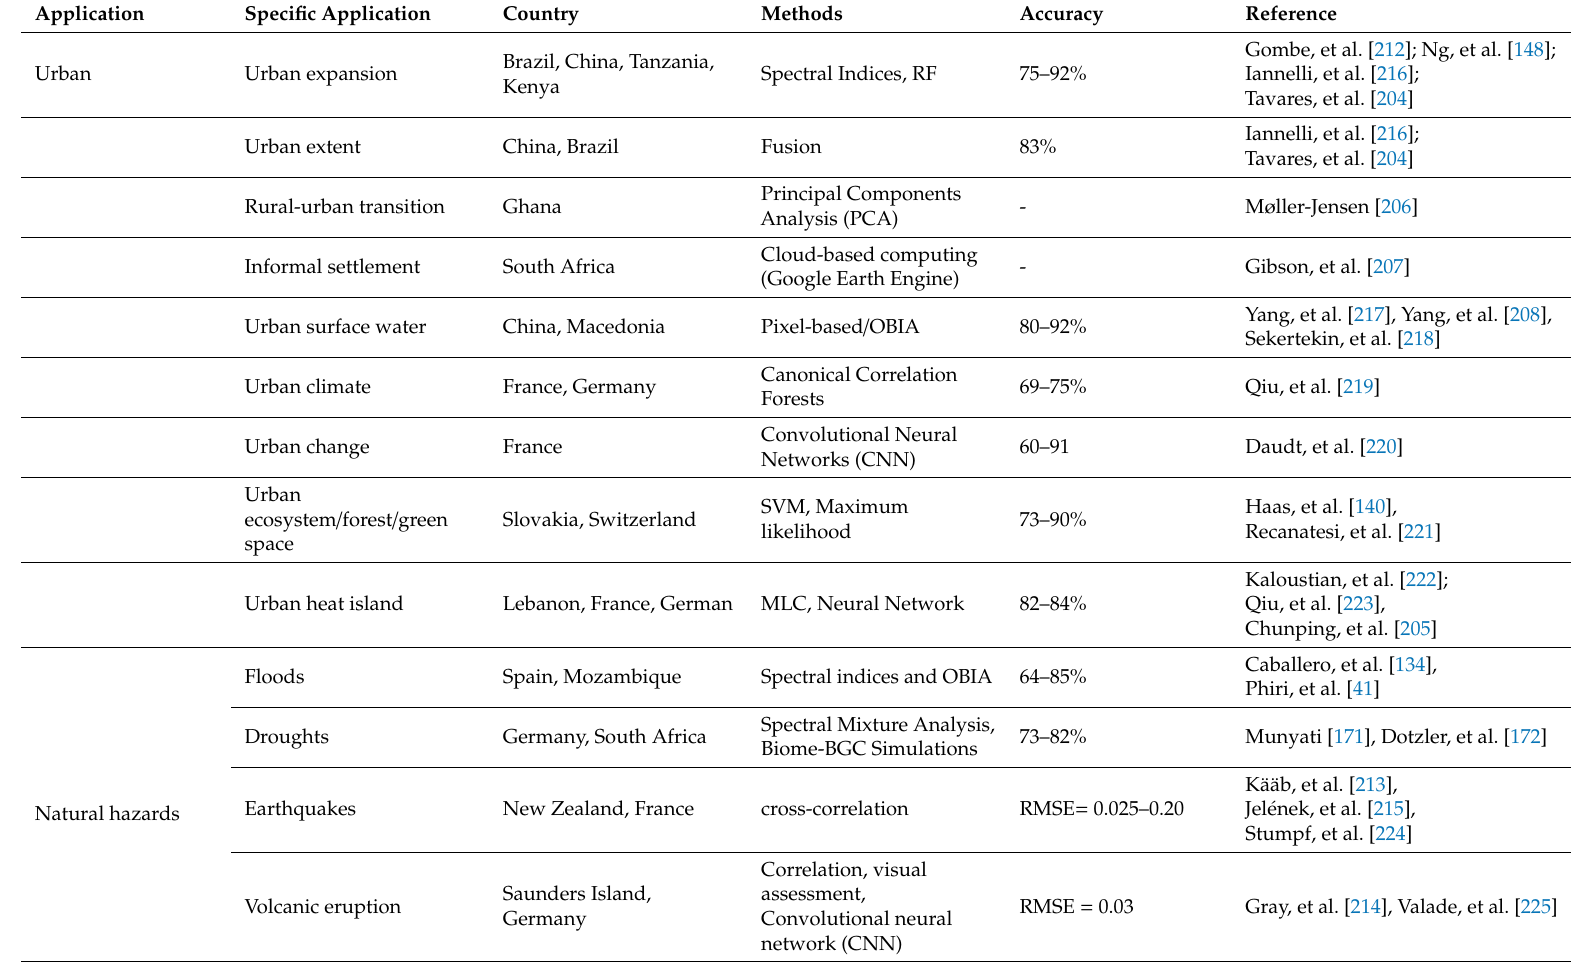
Table 7. Summary of urban and natural hazard application of Sentinel 2